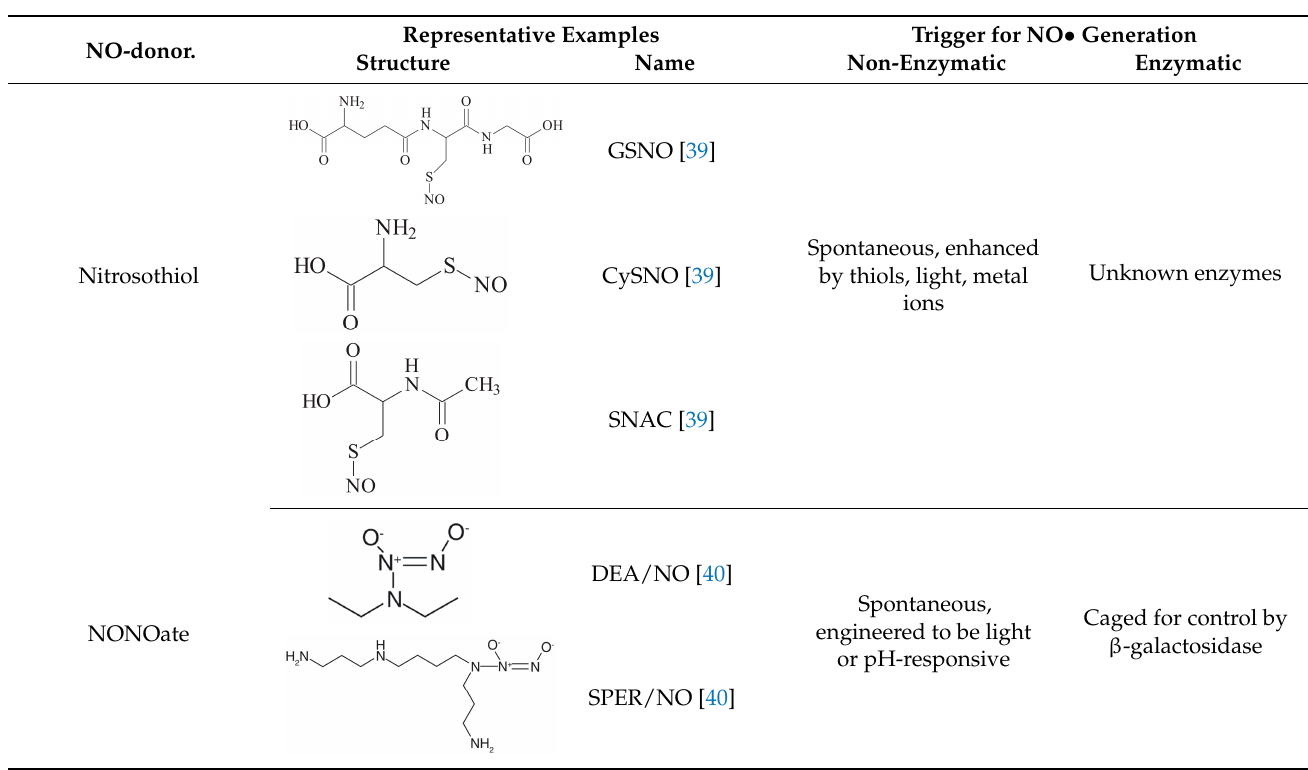
Table 1. Representative NO-donors according to chemical class; adjusted from (33).